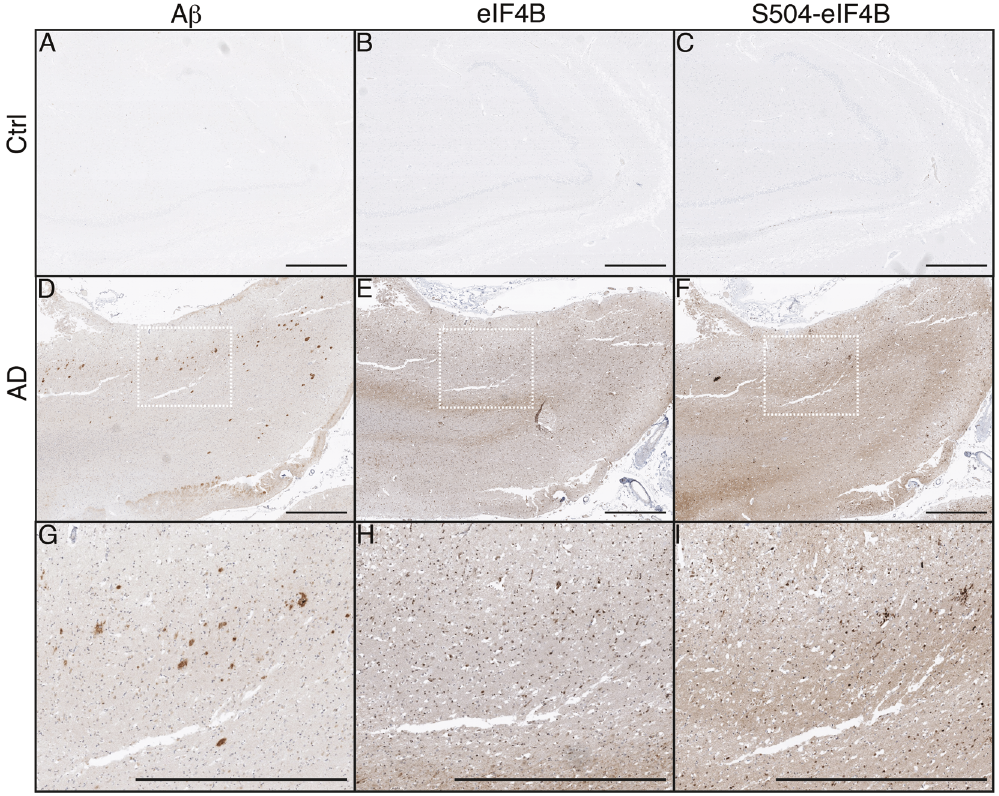
Fig. 6 Expression and phosphorylation of eIF4B are increased in human AD hippocampi. Representative immunohistochemical analysis of human AD and control hippocampal sections ( n = 3) stained for A β ( A , D , G ), total ( B , E , H ), and phospho Ser504 eIF4B ( C , F , I ) showing that both total and phosphorylated eIF4B are increased in the presence of A β pathology. G – I panels are higher magni fi cation images of boxed regions. Scale bars: 1